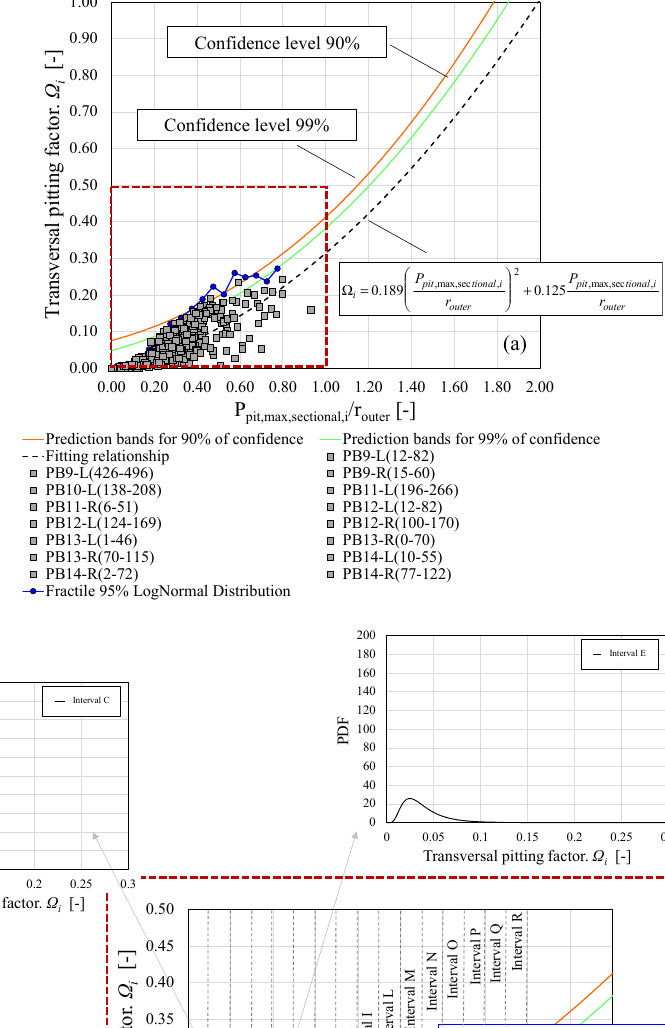
P pit,max,sectional,i /r outer intervals. According to the latter, a noticeable dispersion of Ω i measure- ments is observed for P pit,max,sectional,i /r outer values higher than 0.2.